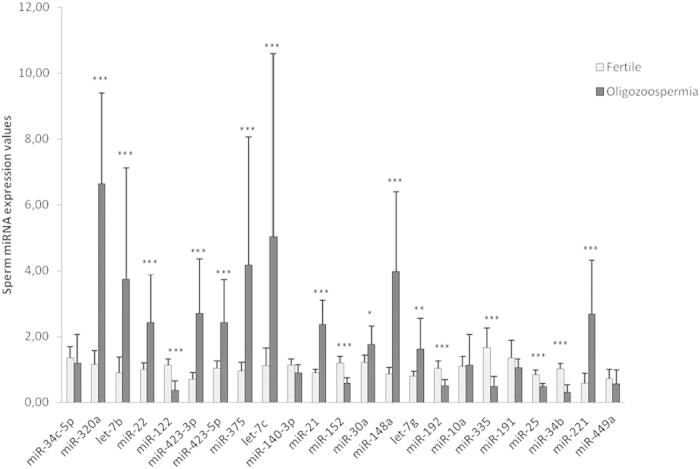
Sperm expression values of selected miRNAs determined by qPCR from fertile (white bars) and oligozoospermic (black bars) semen samples.Normalized expression levels relative to the mean of the twenty-three assays are shown. Significant differences from the control are indicated: *p < 0,05; **p < 0,01; ***p ≤ 0,005 (Mann-Whitney U test).